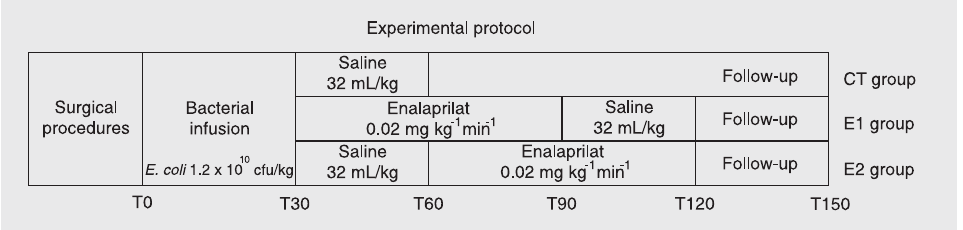
Figure 2. Mean arterial pressure during the experimental proto- col. Data are reported as mean ± SEM. CT (control, N = 4) = fluid resuscitation (T30-T60) group; E1 (N = 5) = enalaprilat (T30-T90) + fluid resuscitation (T90-T120) group; E2 (N = 5) = fluid resuscitation (T30-T60) + enalaprilat (T60-T120) group. a CT, P < 0.05 vs T0; b E1, P < 0.05 vs T0; c E2, P < 0.05 vs T0; d P < 0.05 CT vs E1; e P < 0.05 E1 vs E2